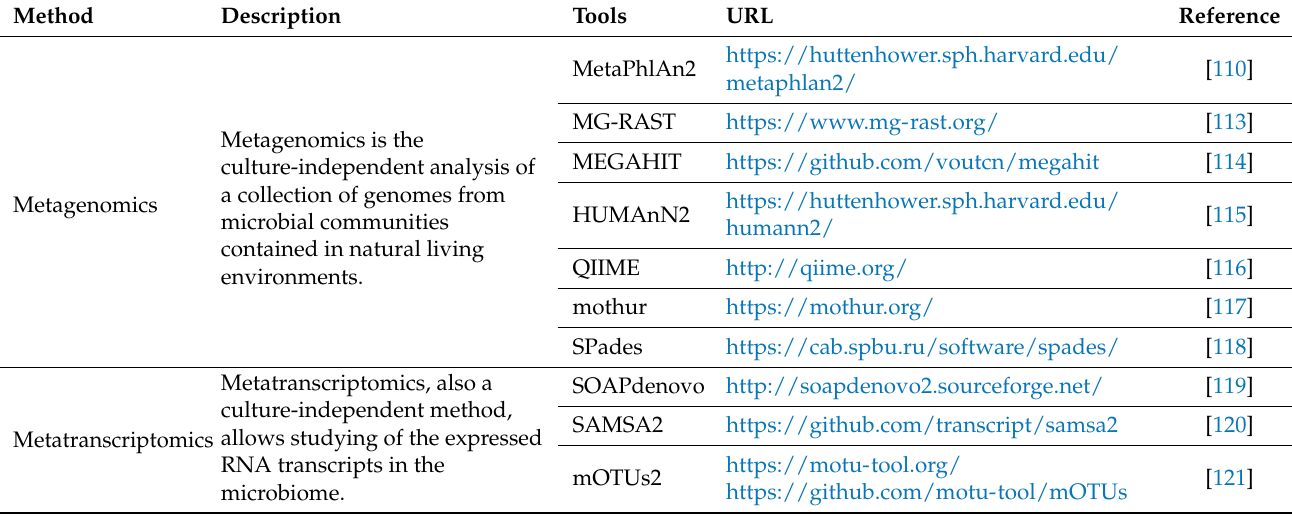
Table 3. List of bioinformatics tools for studying the gut microbiome via methods including metage- nomics and metatranscriptomics (all mentioned URLs were accessed on 28 November